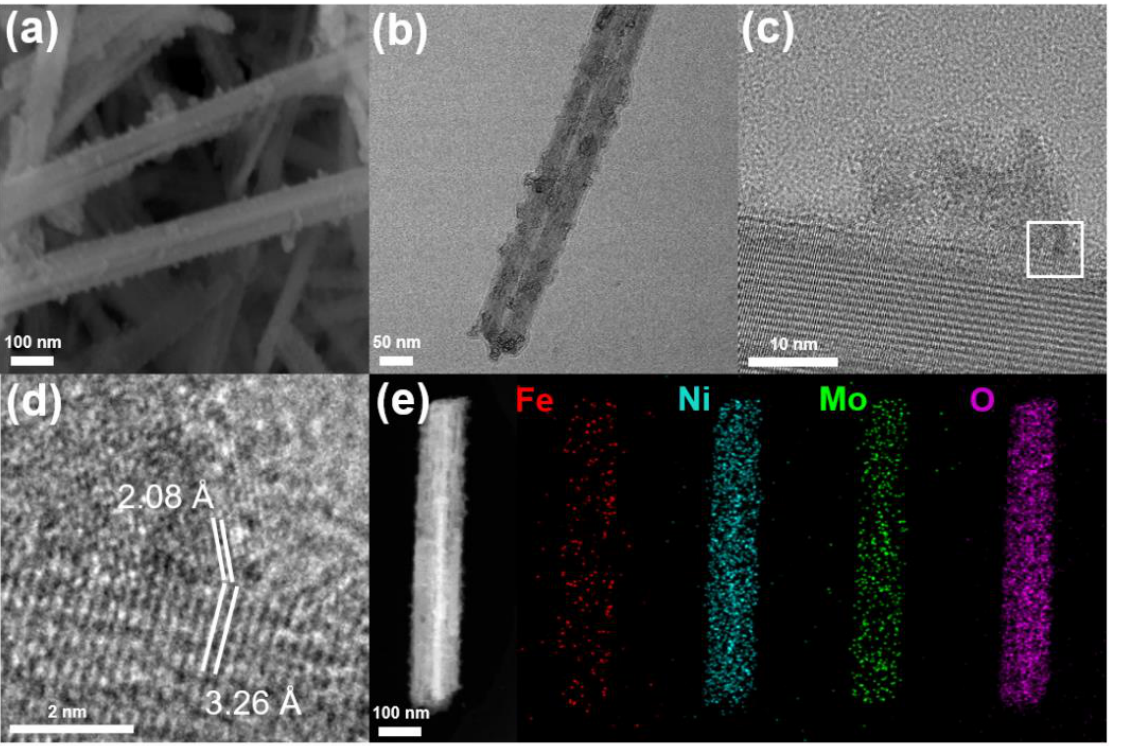
Figure 2. ( a ) SEM image, ( b ) TEM image, and ( c ) HRTEM images of NiFe 2 O 4 /NiMoO 4 ; ( d ) the corresponding HRTEM images of selected areas; and ( e ) EDS mapping images for Fe, Ni, Mo, and O elements of NiFe 2 O 4 /NiMoO 4 .